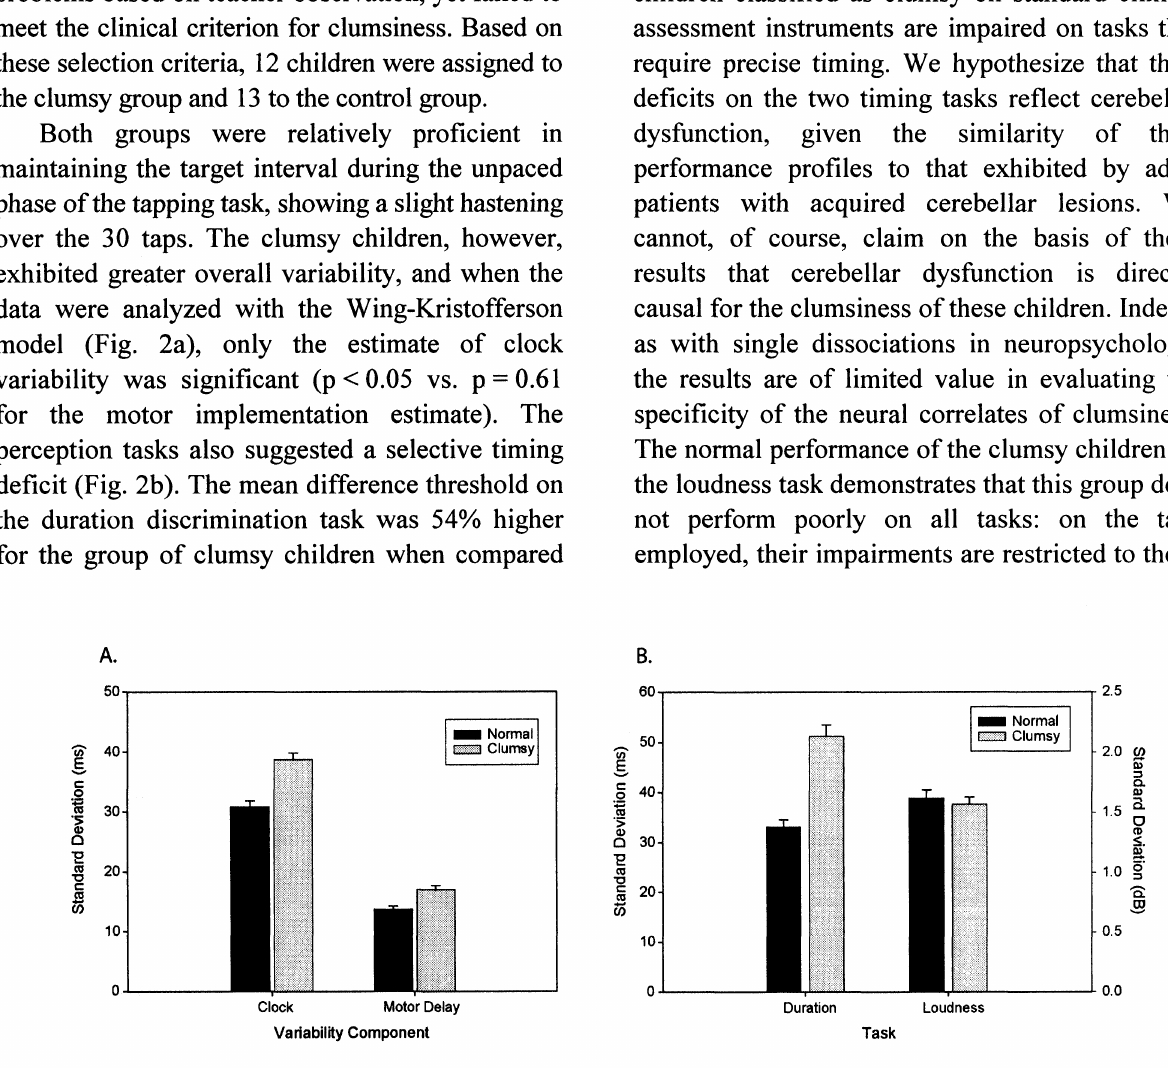
Fig. 2: Performance ofnormal and clumsy children on motor and perceptual timing tasks used to assess cerebellar function, a) Estimates of component sources of variability during repetitive finger tapping. The total variability ofthe inter-tap intervals during the unpaced phase of the trial is assumed to reflect independent contributions from central processes (CLOCK) determining when a response should be initiated and motor implementation processes (MOTOR DELAY), involved in executing the central commands, b) Difference thresholds on two perceptual discrimination tasks, duration (left axis) and loudness (right axis). The values indicate the difference required between the standard and comparison stimuli for the participants to be correct on 75% ofthe trials. Adapted from Williams et al.